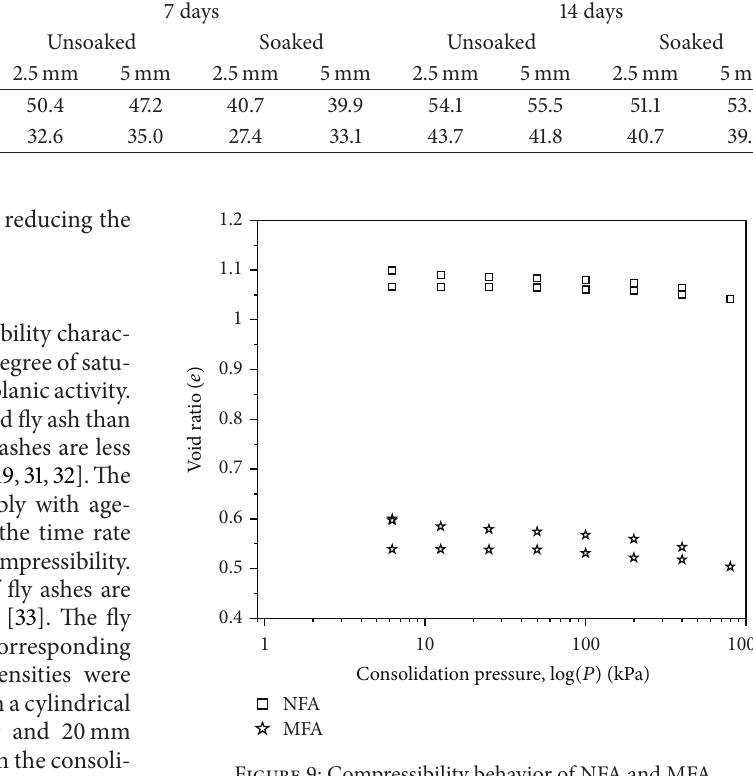
Figure 9: Compressibility behavior of NFA and